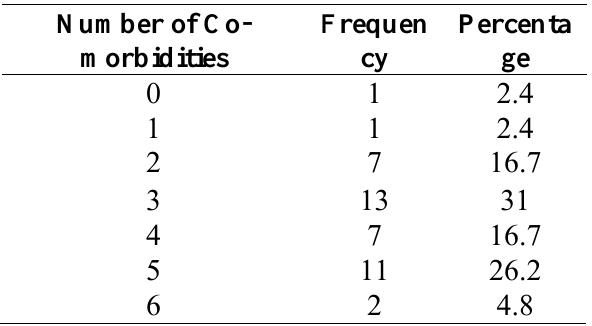
Table 4. Number of Co-morbidities Number of